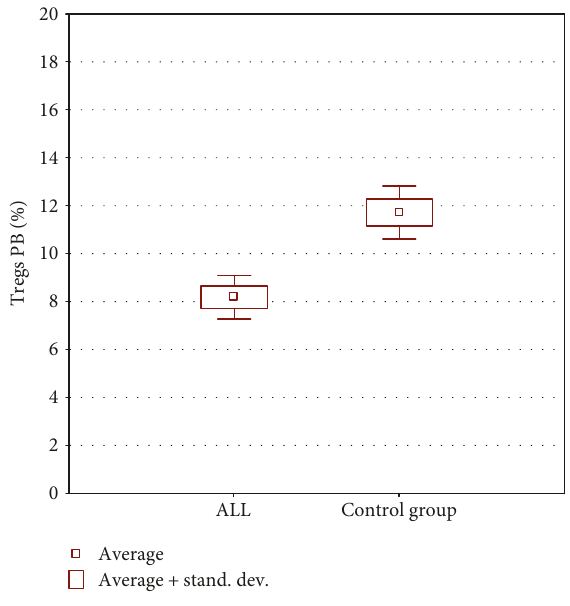
Figure 3: Treg level in peripheral blood among children with ALL versus control group.